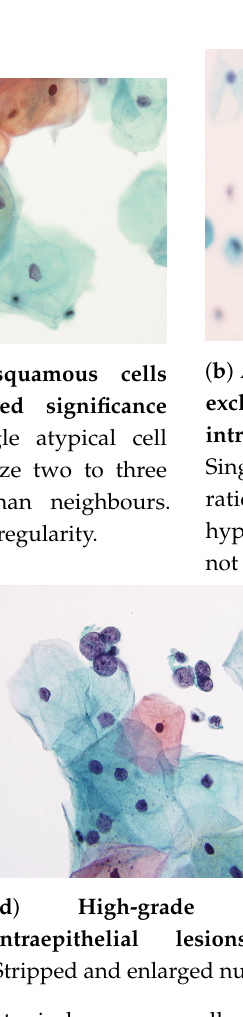
Figure 2. Atypical squamous cells on liquid-based cytology (LBC). From: Nayar, R.; Wilbur, D.